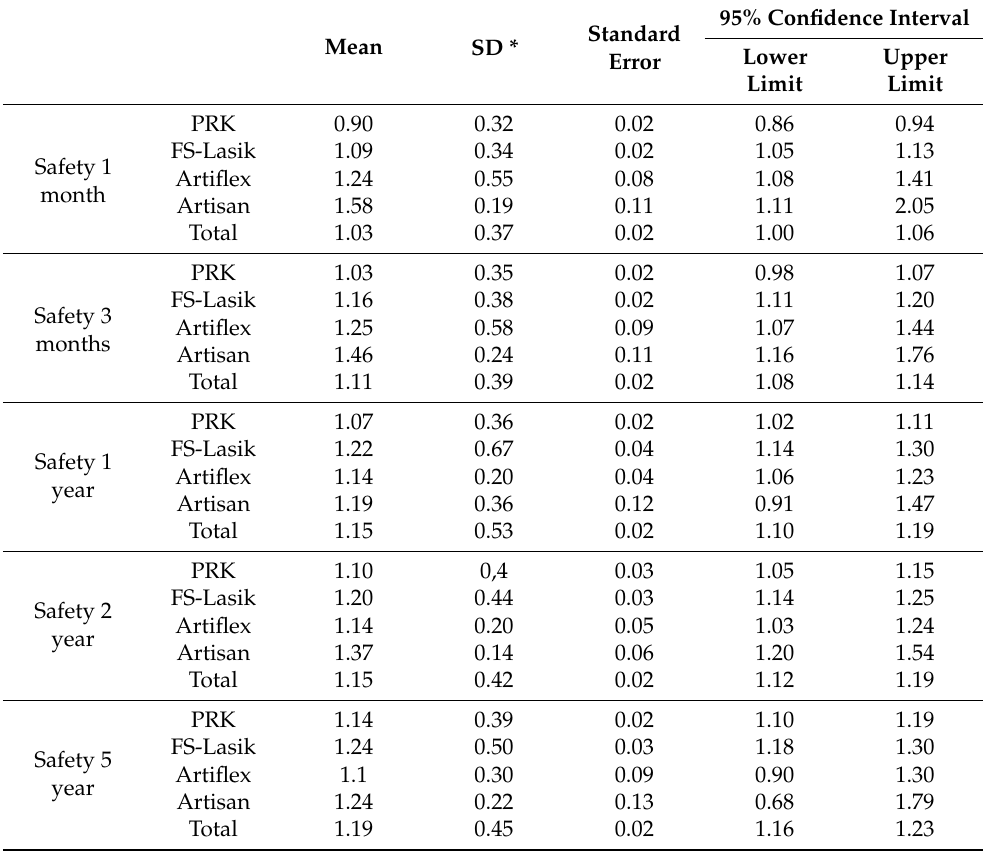
Table 3. Descriptive statistics Safety index according to